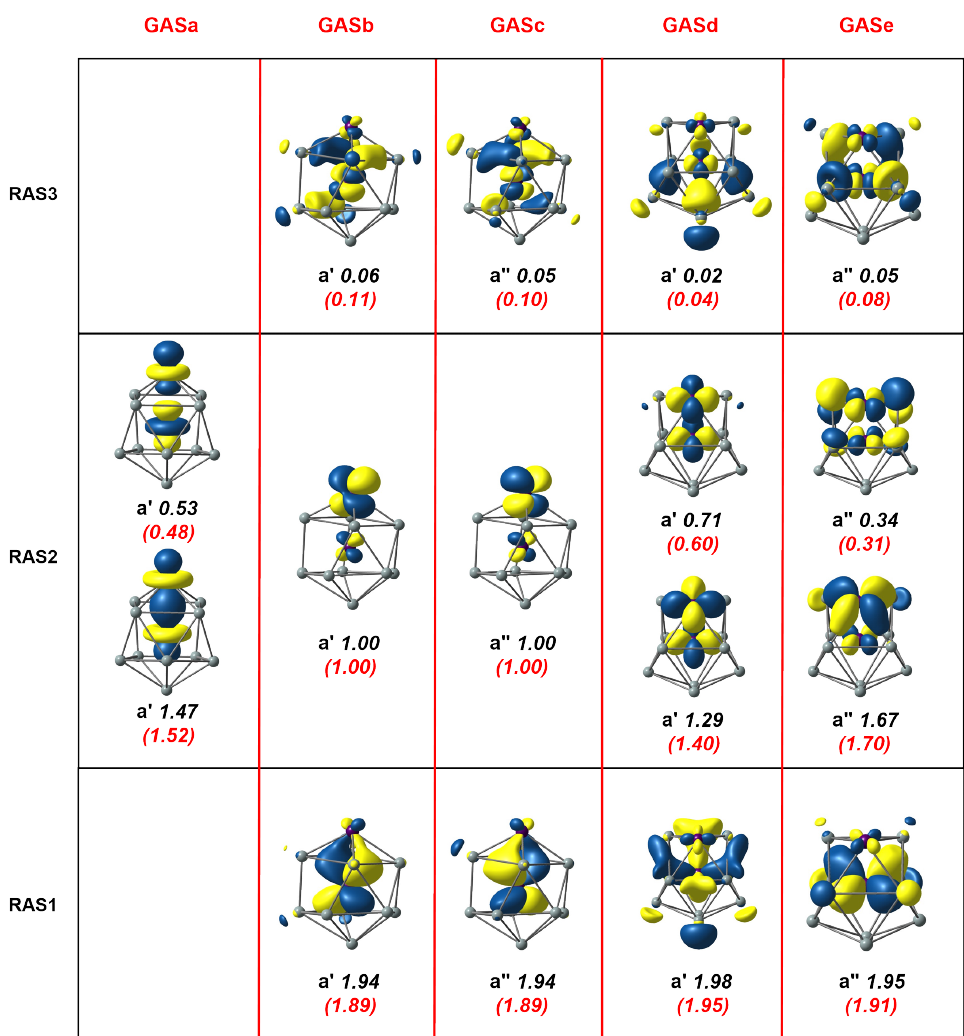
Figure 5. Natural orbitals and occupation numbers for the restricted active space (horizontal) and generalized active space (vertical) of Mn calculation are mentioned in brackets. Calculations on Mn